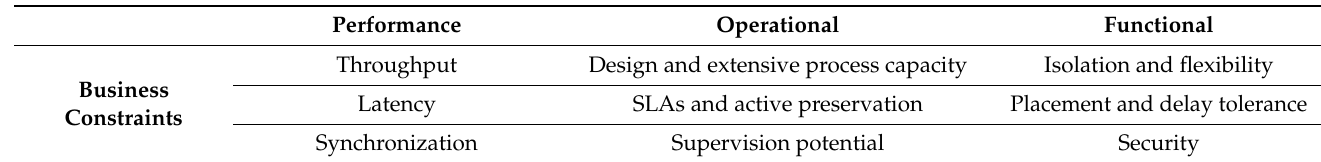
Table 4. Business